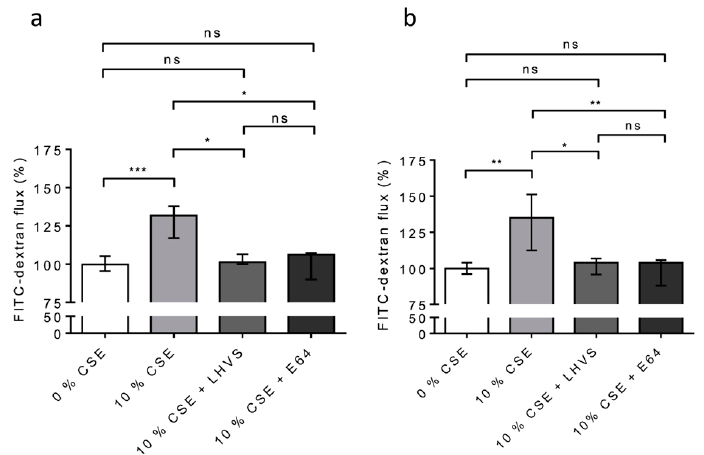
Figure 8. Secreted CatS induced an increase in permeability of lung epithelial cells cultured at the